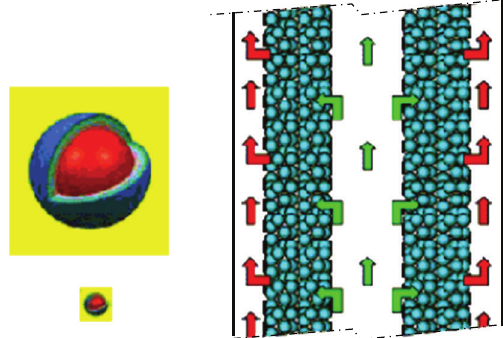
Figure 1: Particle-bed GCFR fuel element